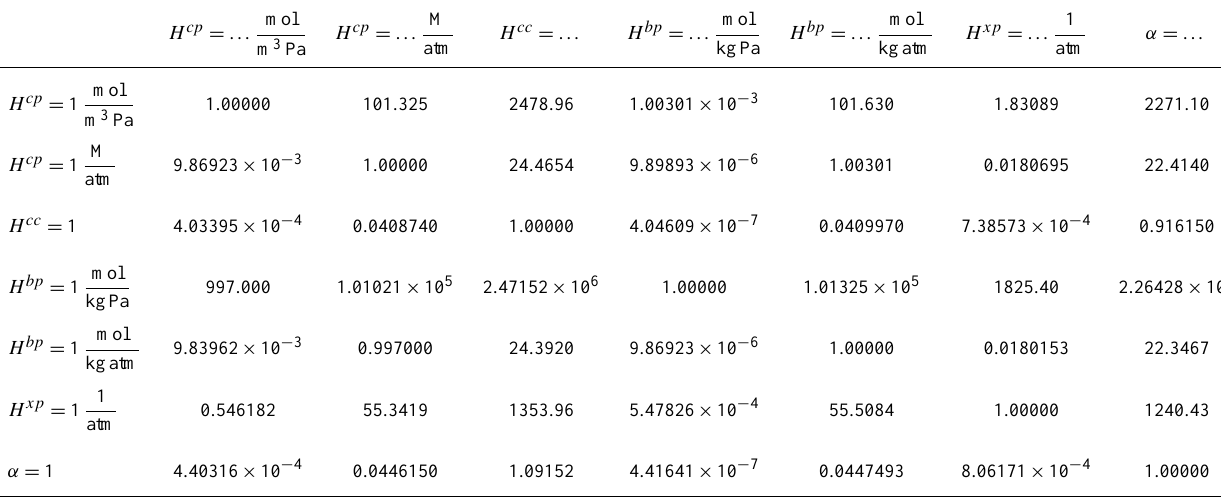
Table 1. Conversion factors between several Henry’s law solubility constants H (at T (cid:9) = 298.15K and % (cid:9) = 997kg m − 3 ).